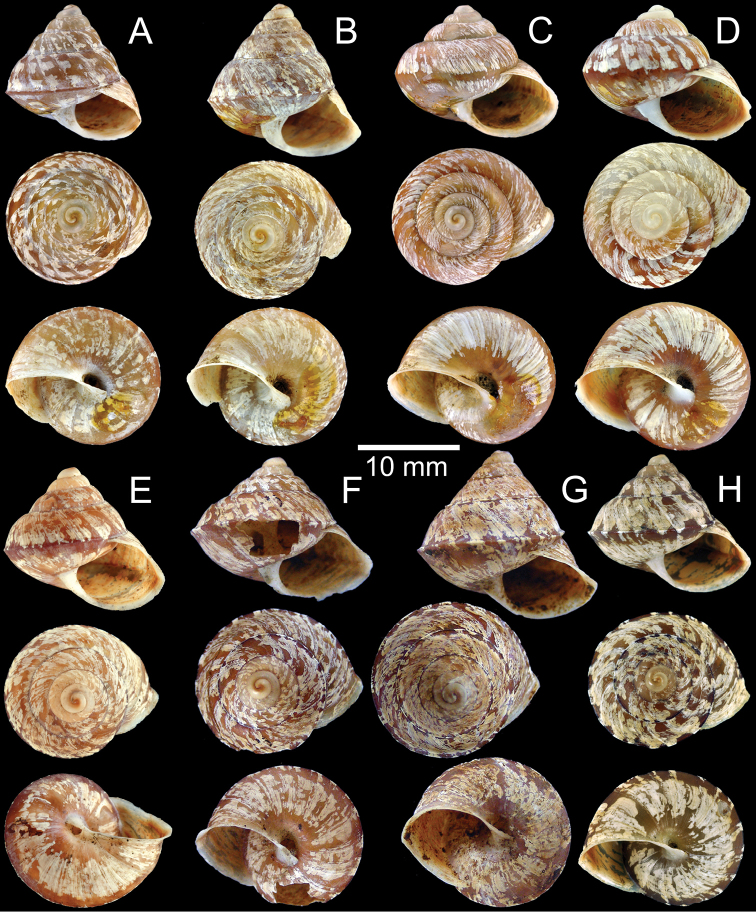
A, BGanesella
capitiumA lectotype UMZC I.102385/1 and B paralectotype UMZC I.102385/2–3 C–EGanesella
hariolaC lectotype UMZC I.104370/1 D paralectotype UMZC I.104370/2–4 and E shell from Popa Mountain, Myanmar CUMZ 5134 F–HGanesella
carinellaF lectotype SMF 27534a G paralectotype SMF 27534b and H shell from Takhli, Nakhonsawan CUMZ 5133.